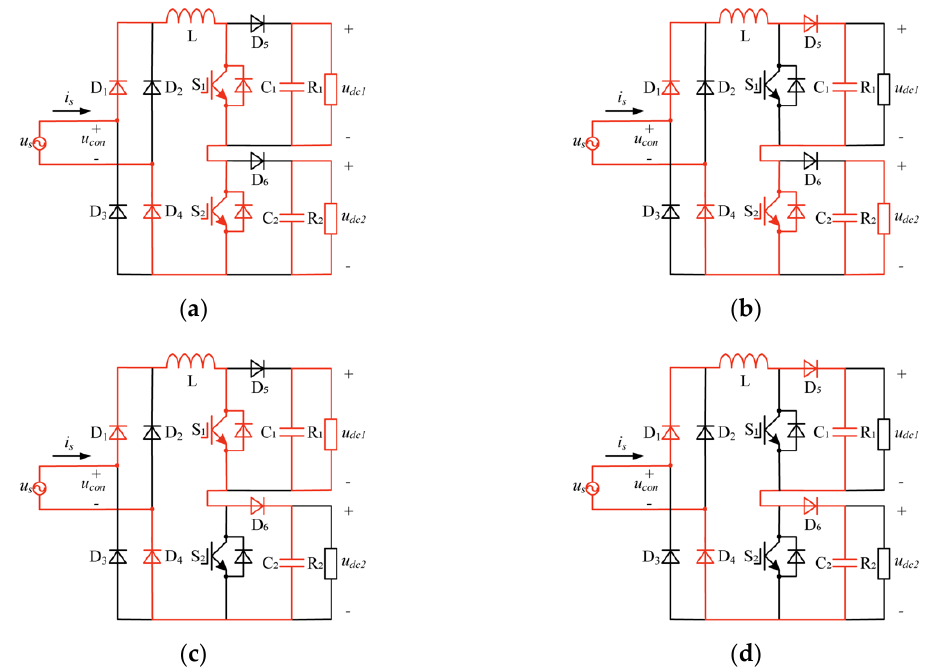
Figure 3. Current paths of the four operation modes for diode H-bridge two-stage cascaded boost rectifier; ( a ) Mode I; ( b ) Mode II; ( c ) Mode III; ( d ) Mode IV.